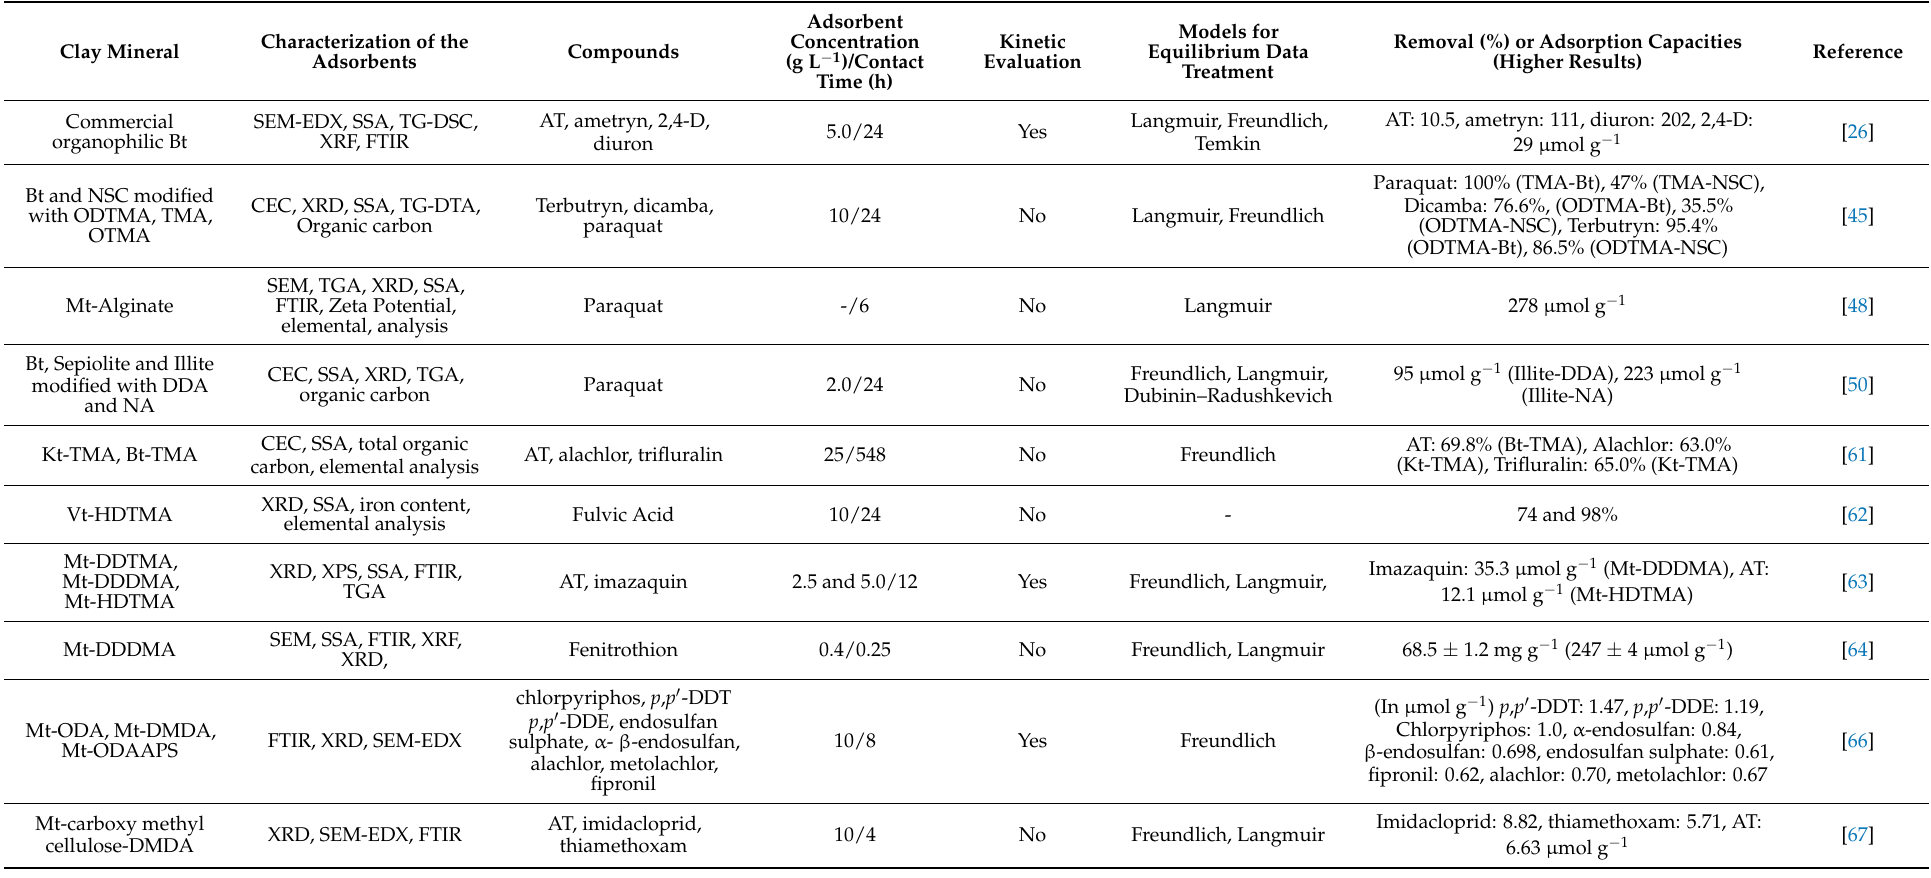
Table 3. Sorbent characterizations and sorption features of pesticides and metabolites onto organically modified clay